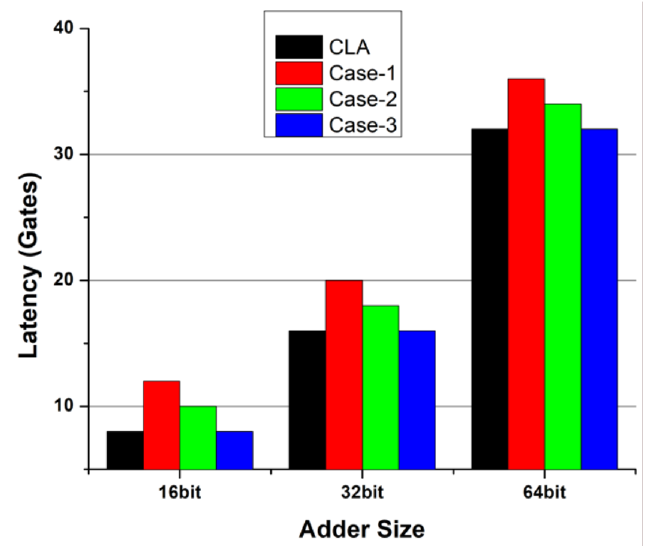
Figure 6. Latency comparison between CLA and case 1–3 of our PRCA-CSeA combinations.